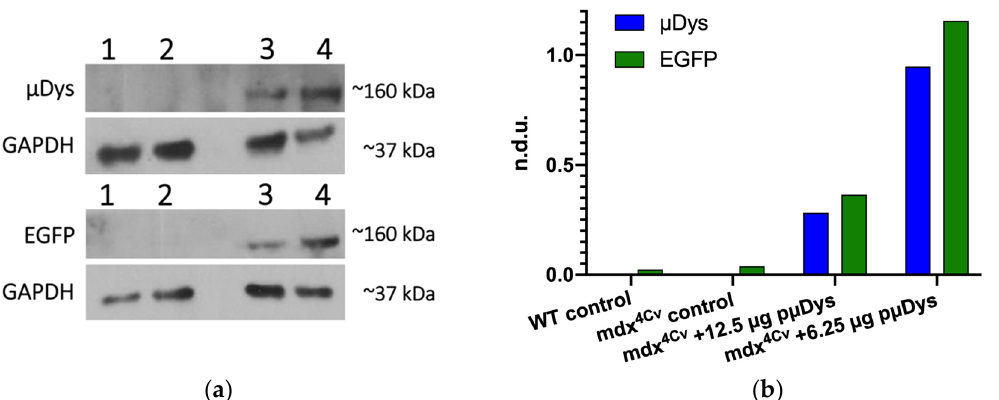
Figure 7. Microdystrophin delivery in vivo . A 1-year-old female mouse with DMD (mdx4Cv) was treated in both legs with 50 µL of concentrated polyplex (12.5 µg pµDys in the left leg, 6.25 µg pµDys in the right leg). After 48 h, protein analysis was performed on leg tissues. ( a ) Western blot analysis of the pooled leg muscles revealed µDys and EGFP expression. ( b ) The µDys and EGFP bands were normalized to the GAPDH bands and the ratios were quantified. 1. Untreated wild-type. 2. Untreated mdx4cv. 3. Treated mdx4cv—left leg muscles. 4. Treated mdx4cv—right leg muscles. Dystrophin (MANEX1011B; DSHB, AB-2618171), EGFP (Abcam, Ab290); n.d.u: normalized densitometry units.